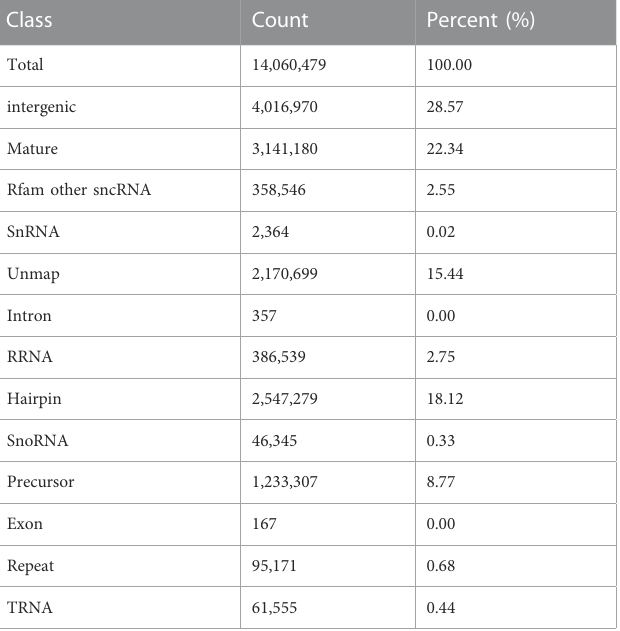
TABLE 2 Summary of small RNA classi fi cation